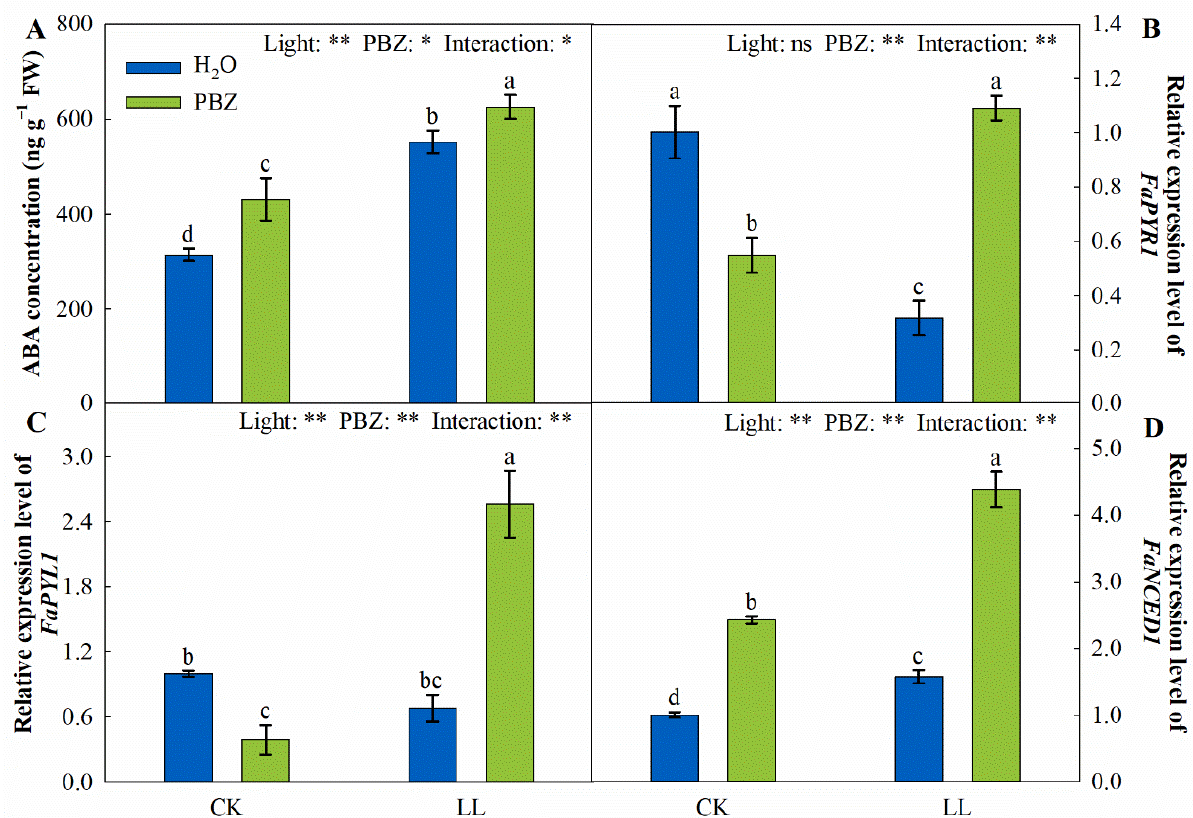
Figure 8. Changes in ABA concentration ( A ), FaPYR1 expression level ( B ), FaPYL1 expression level ( C ), and FaNCED1 expression level ( D ) of tall fescue leaves induced by paclobutrazol under control (CK) and LL stress. * and ** indicate significant differences at p < 0.05 and p < 0.01, respectively. ns indicates not significant. Different letters above the vertical bars indicate significant differences at p < 0.05 according to Duncan’s multiple range test.